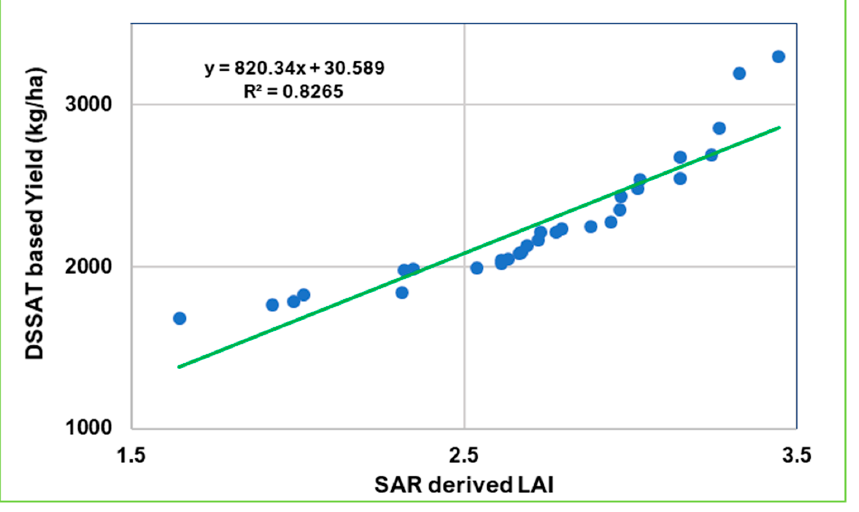
Figure 5. Integration of DSSAT simulated LAI and maximum SAR dB backscattering at pod formation stage.